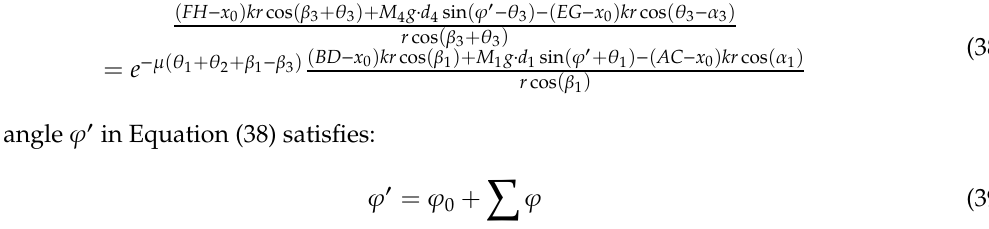
Figure 14. A simplified force model of the robot in Phase 1 after the introduction of gravity, where O1 is the gravity center of Segment 1, O4 is the gravity center of Segment 4, and 𝜑′ is the angle between Segment 2 and the vertical direction.